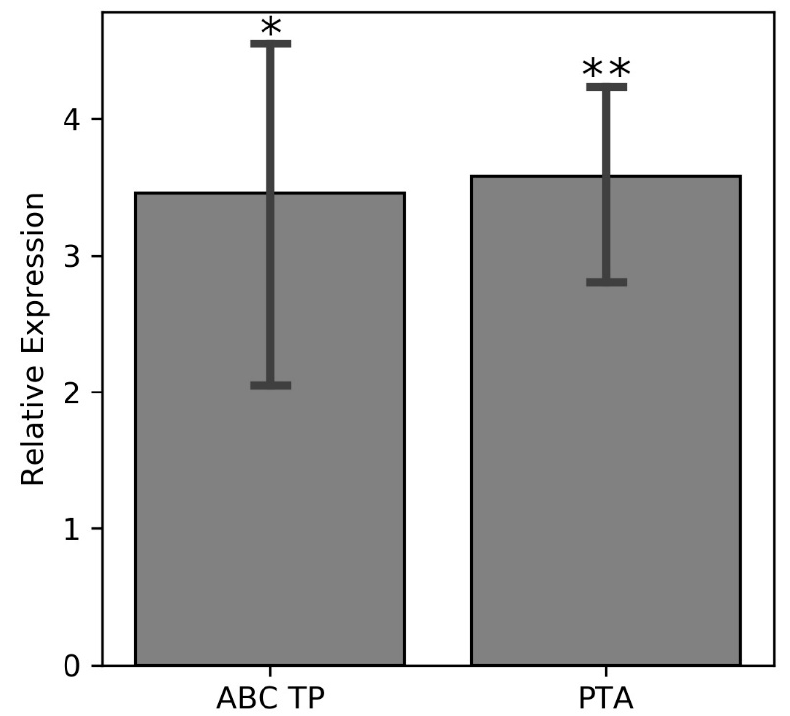
Figure 8. Relative expression levels of the genes for the ABC transporter permease and K + transporter ATPase (COG2060) in the nodules of common beans with qPCR after treatment with 300 mM NaCl treated and untreated (control) plants. (one-way ANOVA; * indicates p ≤ 0.05 while ** indicates p ≤ 0.001). Since Fe exists in two different oxidation states (Fe 2+ and Fe 3+ ), it is a crucial com- ponent of redox reaction in respiration and photosynthesis [83]. Genes involved in Fe transport from nodule bacteroids to the host plant cells code for hemin, siderophore, and enterochelin biosynthesis enzymes and are upregulated under salt stress. It has been hy- pothesized that upon entry into the plant tissues, these molecules are further transported to the rhizosphere through plant sidorophore efflux mechanisms [84,85] to enhance Fe absorption from the soil by the salinity stressed plants. Furthermore, in addition to Fe, siderophores produced by Bacillus subtilis , Arthrobacter sulfonivorans , and Enterococcus hirae increased zinc mobilization in wheat genotypes